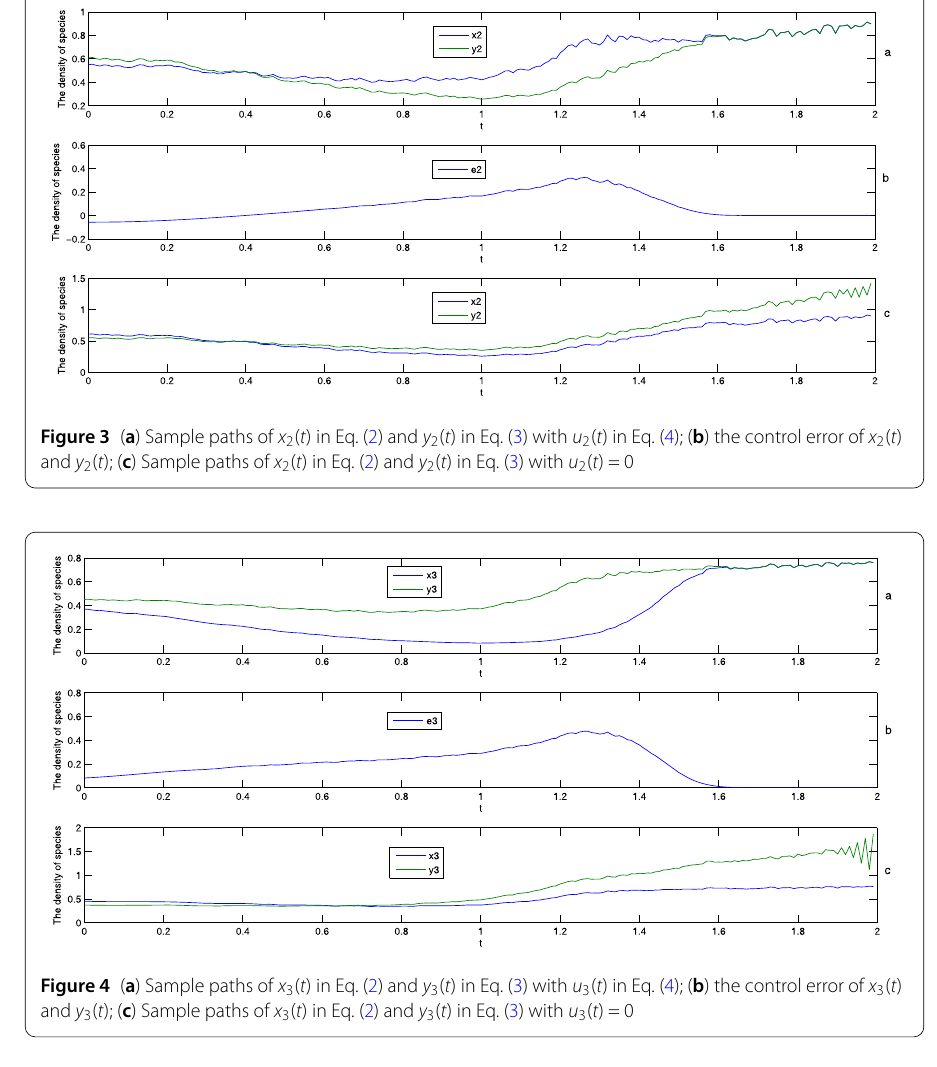
Table 1 Results for resource consumption Resource Utilization Available Utilization LUT 1061 53,200 1.994 LUTRAM 65 17,400 0.374 FF 1334 106,400 1.254 BRAM 1.5 140 1.071 BUFG 1 32